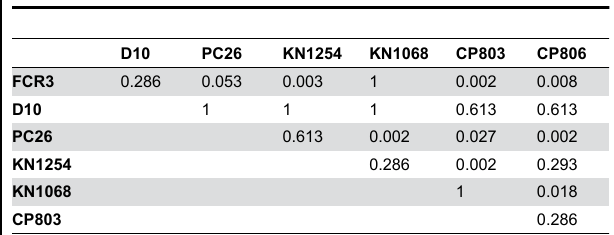
Table 4. Contingency analysis to determine whether IgG responses to parasite strains correlate with each other: post-transmission season.